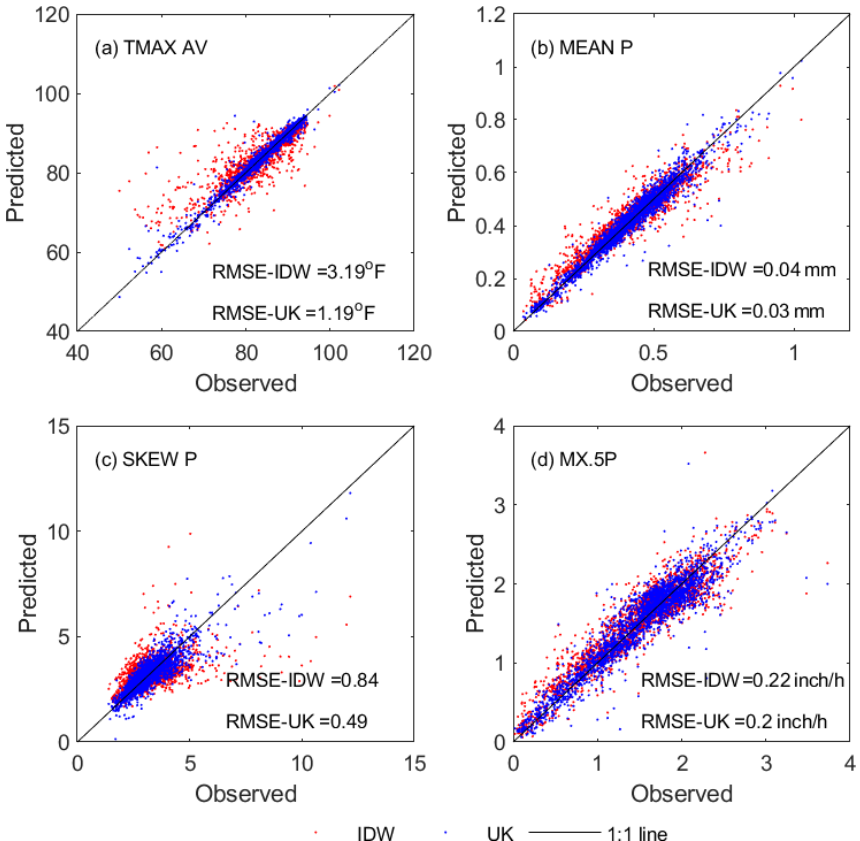
Figure 10. Comparison of interpolation quality using universal kriging (UK) and the inverse distance weighted method (IDW) for CLIGEN temperature- and precipitation-related parameters for 2405 stations in